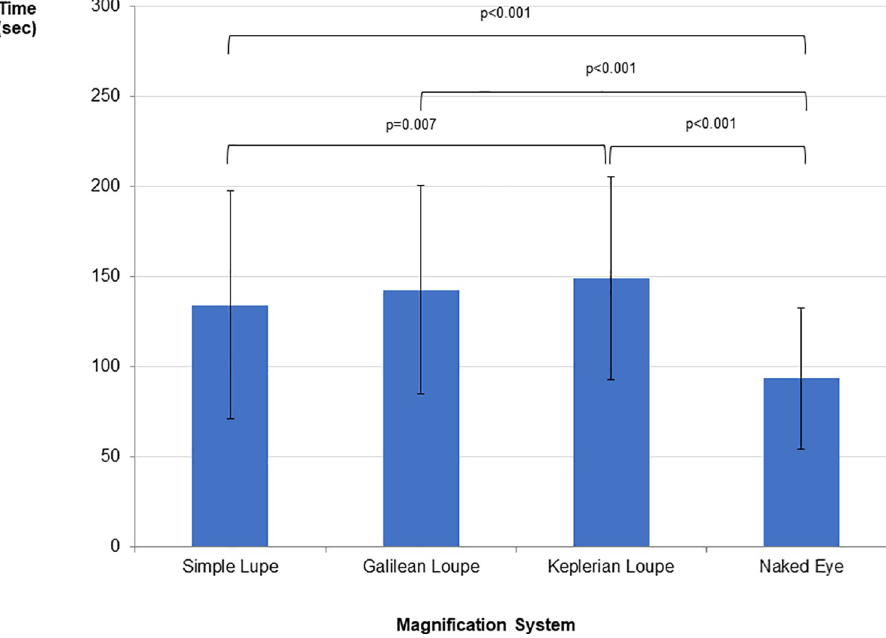
Fig 4. Mean, standard deviation, and summary of repeated measures Anova for the time required to complete the DMDA for each magnification system. Repeated measures ANOVA: SS = 172369.899; df = 3; MS = 57456.633; F = 78.466; p < 0.01; η p 2 = 0.463; π = 1.00; Horizontal lines indicate statistically significant difference between means according to the Bonferroni post-hoc